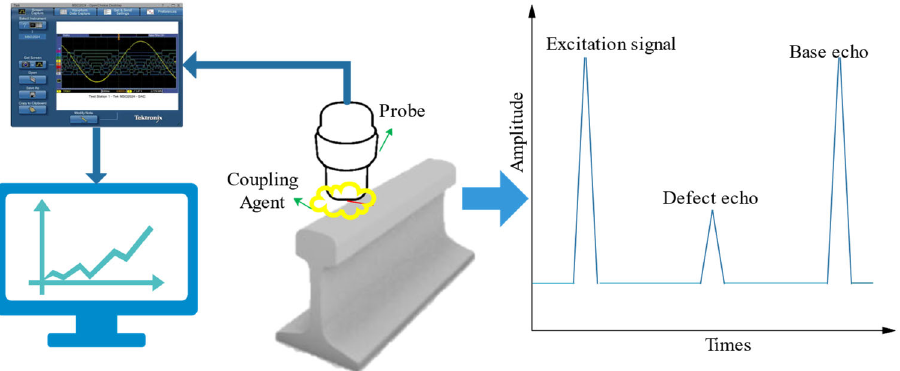
Figure 2. Ultrasonic NDT for rail.